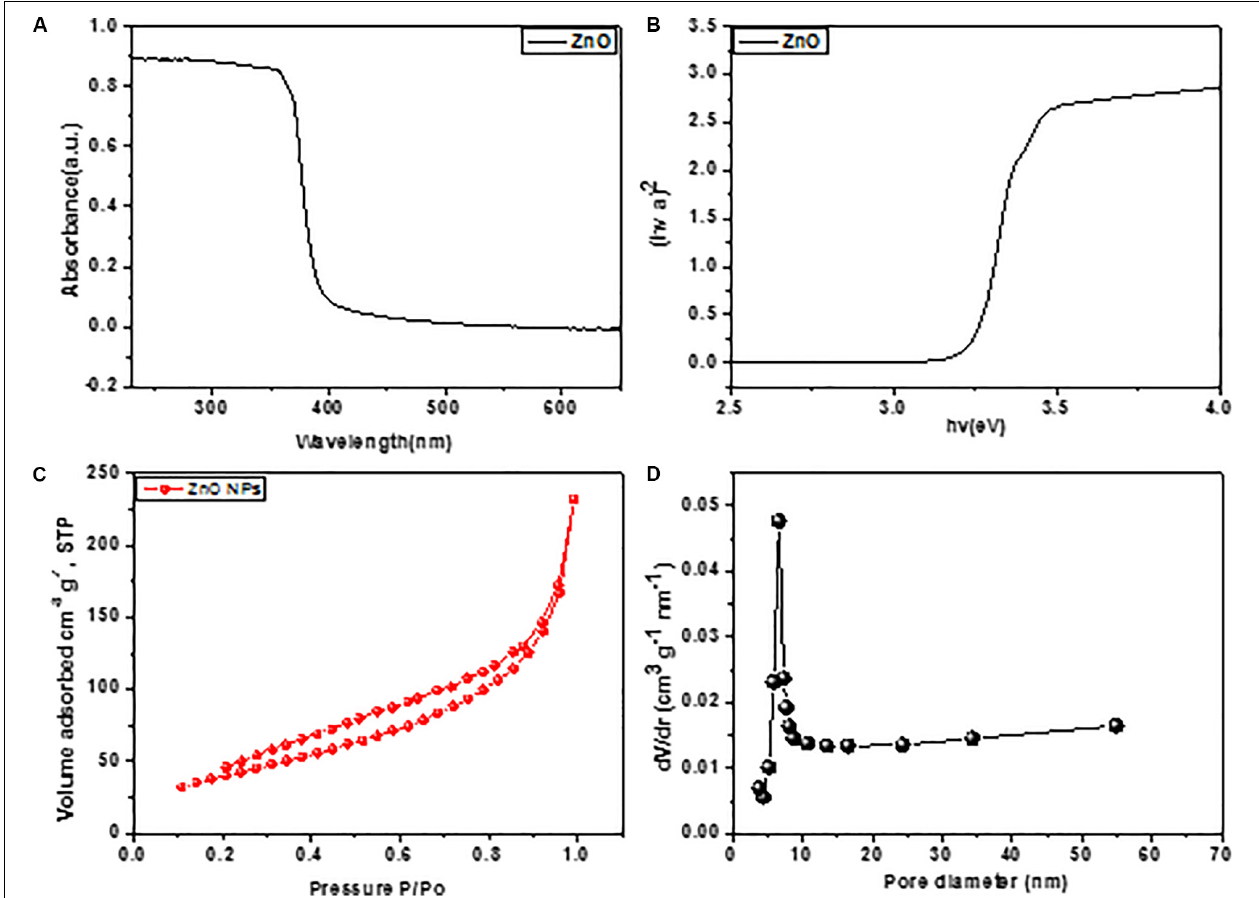
FIGURE 3 | (A) UV-vis spectra of ZnO and (B) ZnO with the corresponding plots of [F(R ∞ )hv] 2 vs. hv. (C,D) N 2 adsorption–desorption isotherms and pore size distributions of ZnO nano